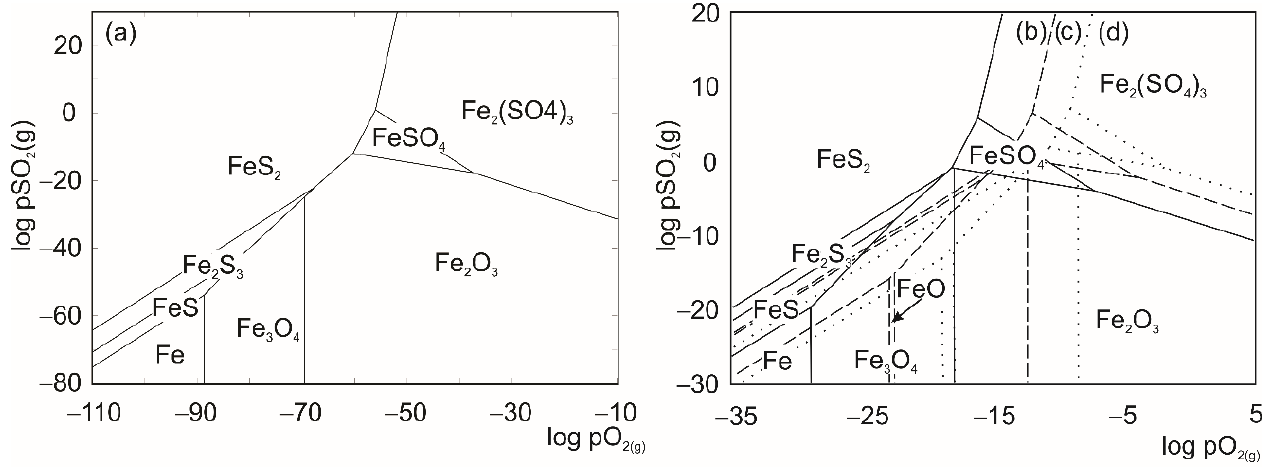
Figure 4. Kellogg diagrams constructed for Fe ‐ S ‐ O system at ( a ) 298 K, ( b ) 773 K, ( c ) 923 K and ( d ) 1073 K [37,38]. Regarding the constructed diagrams, the theoretically proposed reaction paths for Ni ‐ S ‐ O and Fe ‐ S ‐ O systems are presented in Table 3.